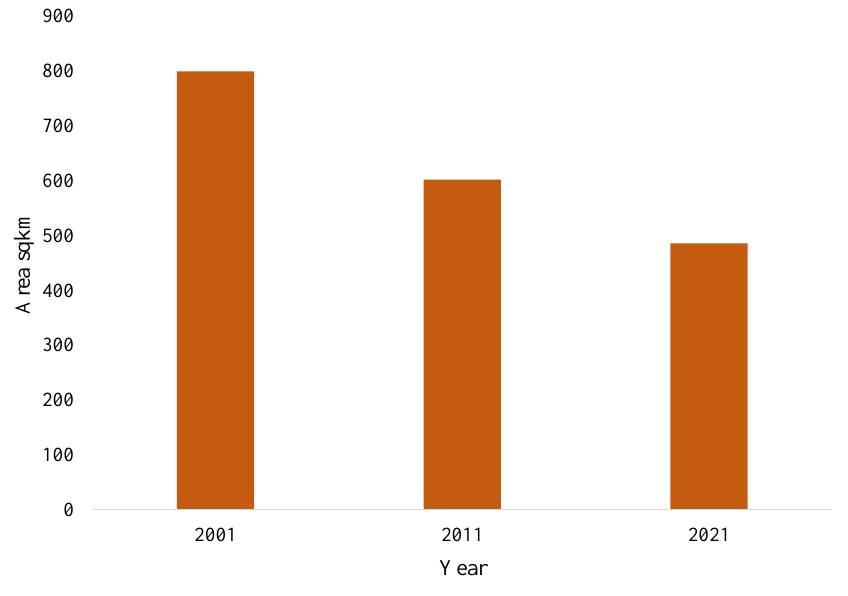
Figure 5. Column graph showing comparative vegetation change for 2001, 2011, and 2021. The study also identified that the waterbody covered 34.28 km 2 in 2001. In 2011, the waterbody area had declined to 30.42 km 2 , and it decreased again to 24.69 km 2 in 2021. Water bodies show an entirely decreasing trend with increasing urbanization. Figure 6 shows the trend in the waterbody decrease in the study area.